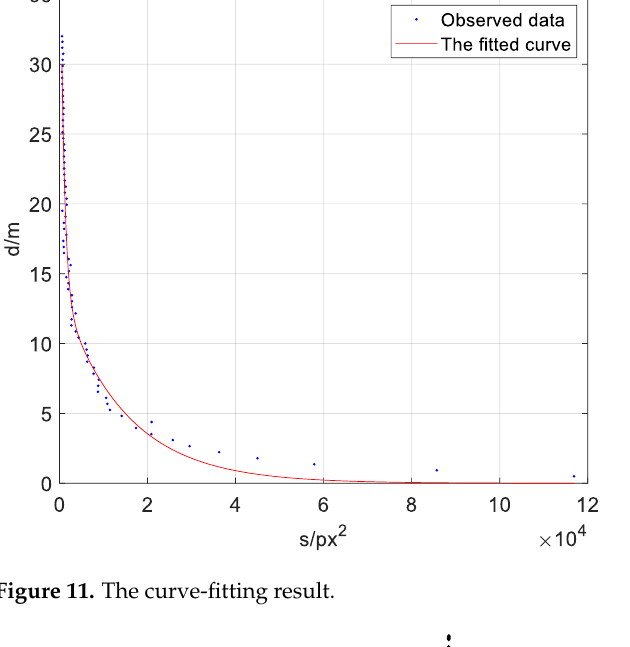
Figure 11. The curve-fitting result.